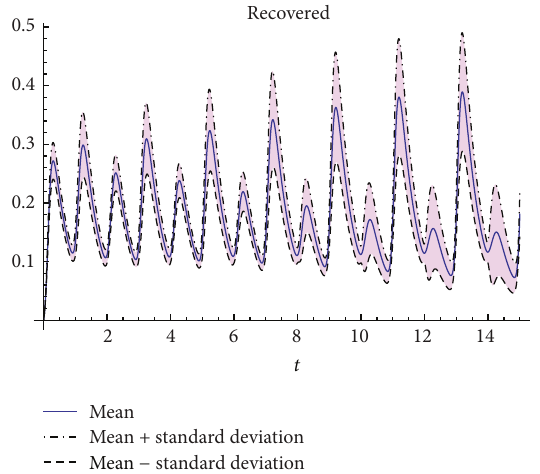
Figure 12: Approximations of the expectation (solid line) and plus/minus standard deviation (dashed lines) to recovered ( 𝑅(𝑡) ) on the interval [0, 15] in Example